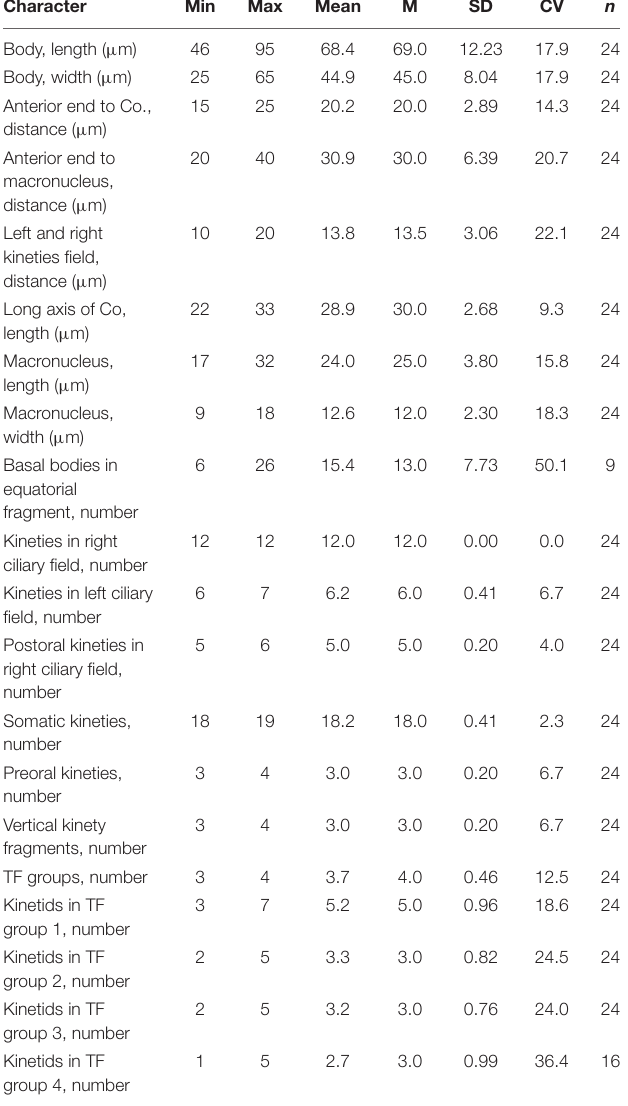
TABLE 2 | Morphometric data of Gastronauta paraloisi sp.